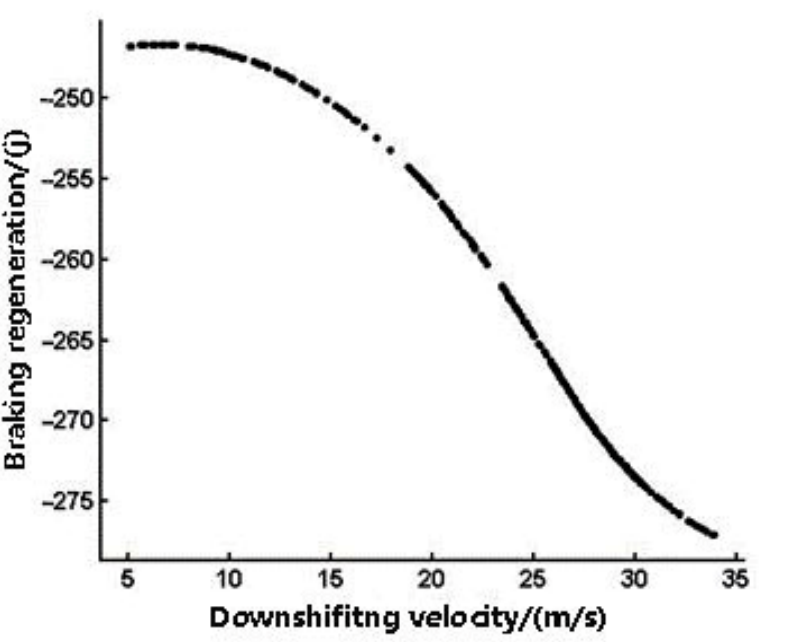
Figure 13. Braking regeneration energy under different downshifting velocities. The three variables acceleration a s , motor torque T ms , and vehicle velocity v are sampled to calculate rr . These variables are discretized, as shown below.